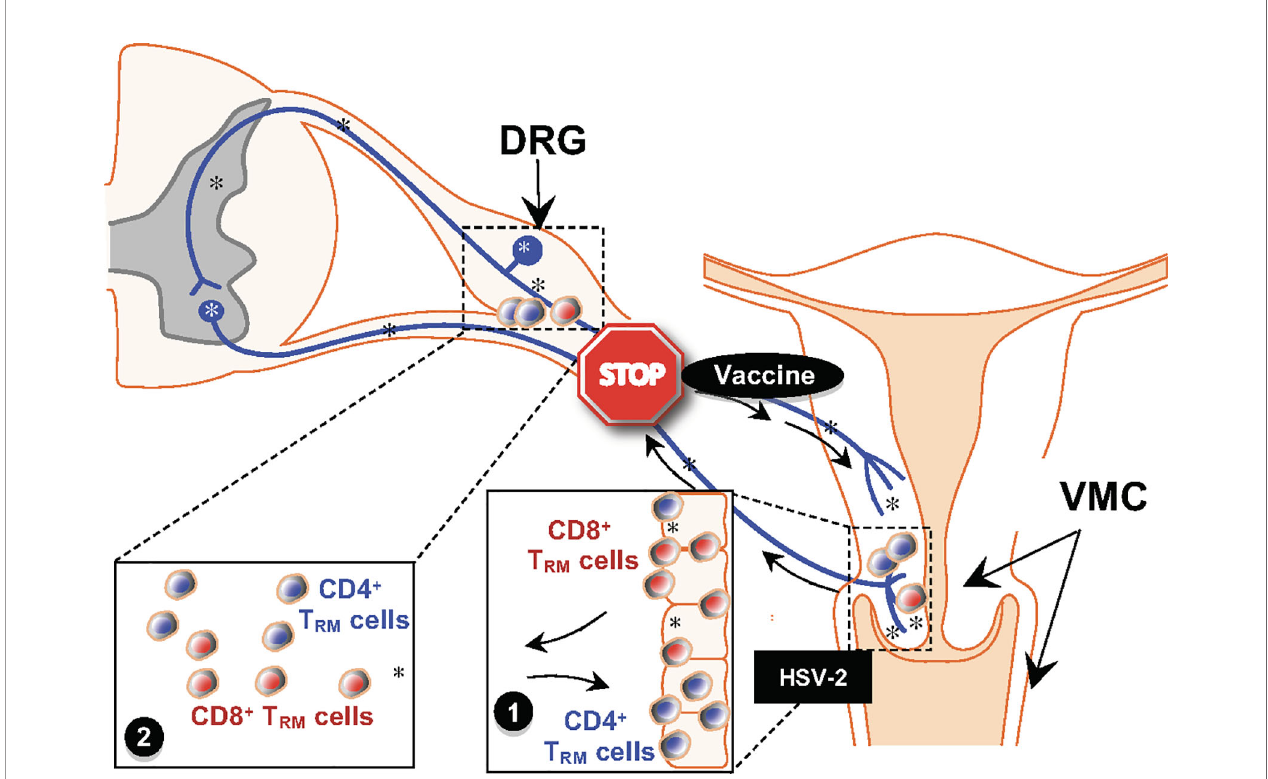
FIGURE 1 | Schematic of Prime-Pull-Keep Therapeutic Vaccine (PPK Vaccine). The PPK vaccine is designed to boost Neutralizing IgG/IgA antibodies (Abs) and boost the number and function of antiviral CD4 + and CD8 + T RM cells within the cervico genital muco-cutaneous [CGMC, (1) ] and dorsal root ganglia [DRG (2) ] tissues. The PPK vaccine is expected to help STOP the virus reactivation from latently infected DRG, virus shedding and virus replication in CGMC, thus curing or reducing recurrent genital herpes disease. *, represent